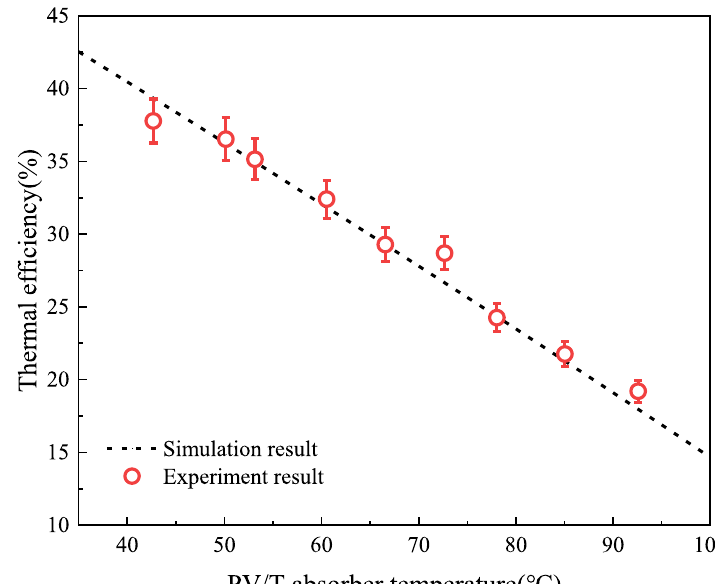
Fig. 13 Numerical and experimental data of the thermal efficiency